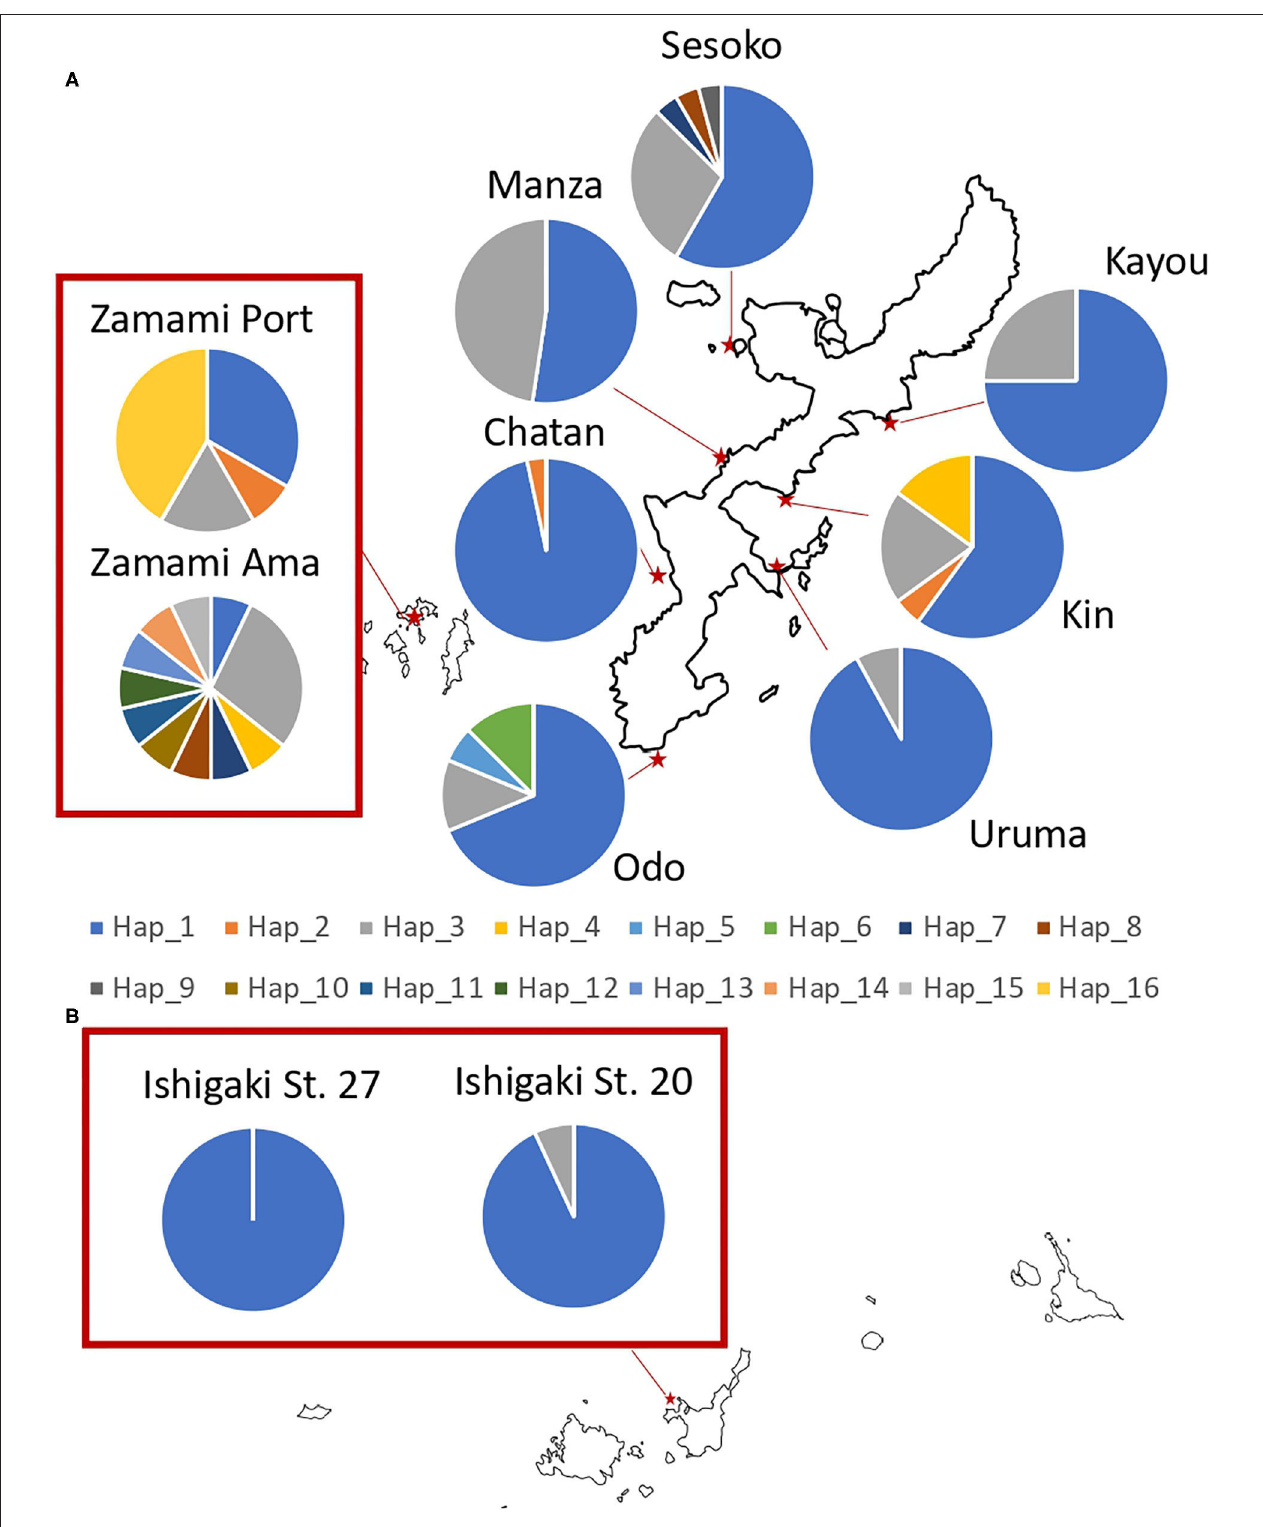
FIGURE 3 | Sampling locations of H. atra with the proportion of each 16S haplotype in (A) Okinawajima Island and the Kerama Islands, and (B) Ishigaki Island. Each color indicates a different haplotype.